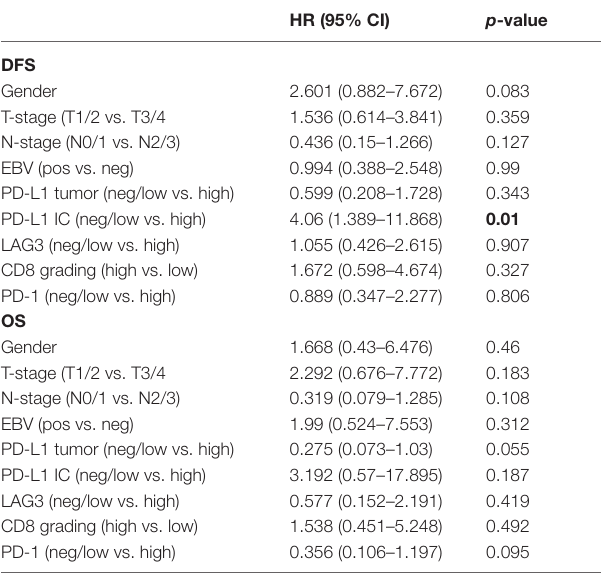
TABLE 3 | Association of DFS and OS with clinical and pathological